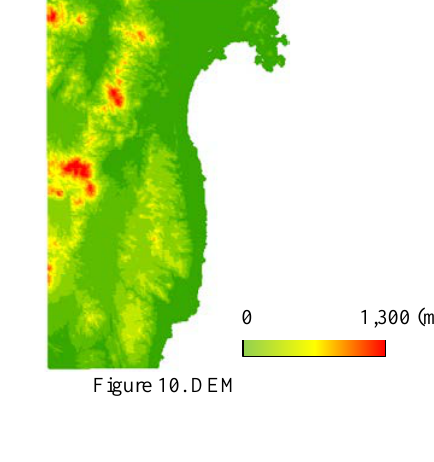
Figure 9. Main pollution routes for Iidate. The overlapped atmospheric pollution map shows almost a normal distribution. From the altitudes in DEM(Figure10), the deposit ratios were assumed to be 0.3 on the adverse slopes and 0.1 on the downward slopes, and Figures 11 and 12 were obtained.